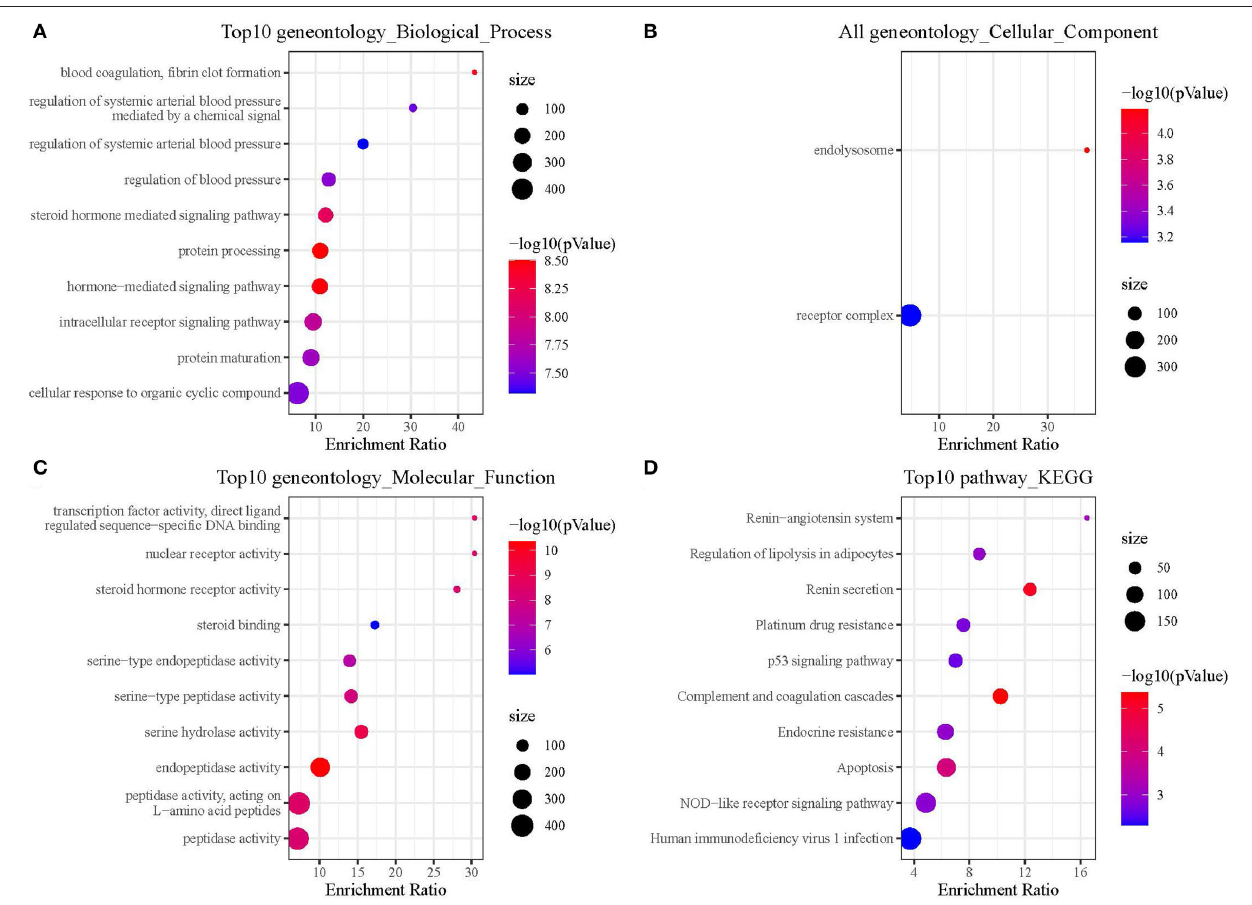
FIGURE 4 | Functional enrichment analysis of hub genes. (A) Hub genes were enriched in biological process. (B) Hub genes were enriched in cellular component. (C) Hub genes were enriched in molecular function. (D) Hub genes were enriched in KEGG